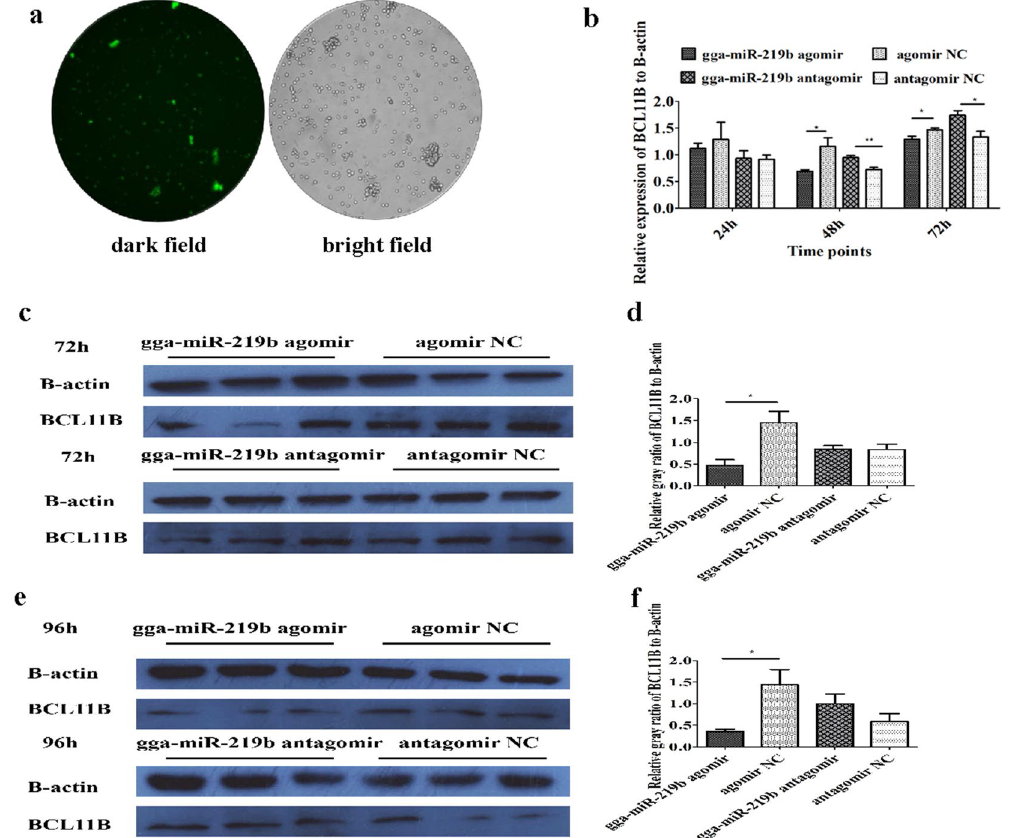
Figure 3. Effect of gga-miR-219b on BCL11B at the transcriptional and translational level. ( a ) Depiction of the miRNA agomir or antagomir transfection efficiency. To show transfection efficiency of the agomir or antagomir, a transfection reagent was used to transfect MSB1 cells with FAM-labelled agomir NC. A fluorescence microscope was used to observe the cells, which were illuminated under a bright field or dark field with magnification at 100 × . ( b ) mRNA expression level of BCL11B after transfection with the miRNA agomir, antagomir or respective NC into MSB1 cells at 24 h, 48 h and 72 h (n = 4). ( c – f ) Protein expression level of BCL11B after transfection with the miRNA agomir, agomir NC, antagomir or antagomir NC into MSB1 cells at 72 h ( c , d ) and 96 h ( e , f ) (n = 3). The results of western blotting ( c,e ) and a diagram depicting the grey- scale values of BCL11B relative to β -actin are shown ( d,f ). The blots were cropped and full length blots were presented in Supplementary Figs S8–S13. Differences between two groups were analysed by Student’s t -test with the SAS system. The data are expressed as the mean ± S.E. * P < 0.05. ** P <